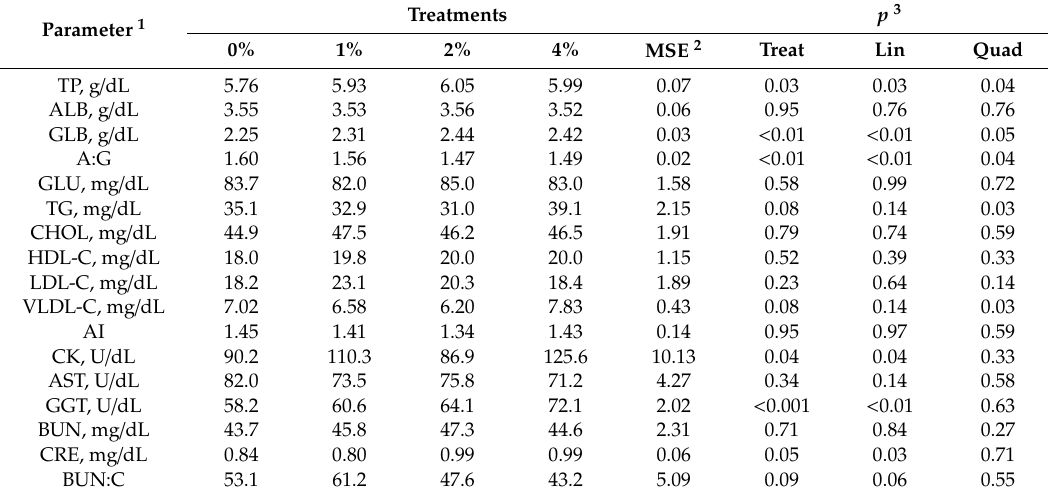
Table 3. Blood biochemical parameters of growing lambs fed increased levels of yerba mate extract. Parameter 1